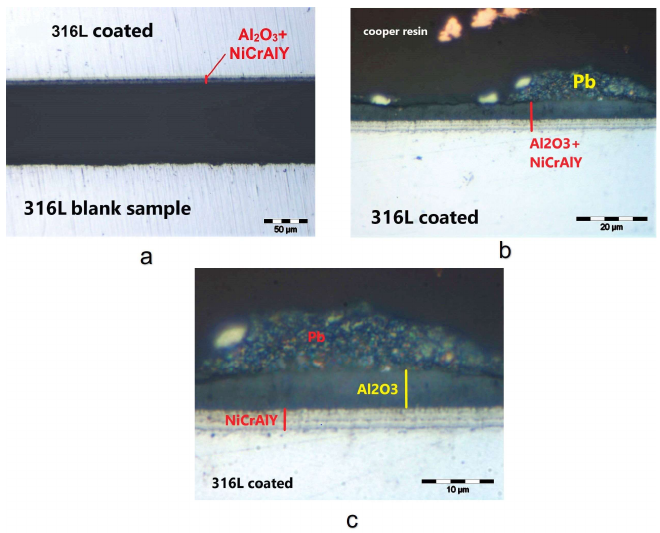
Figure 13. Cross section of the AISI 316L coated samples after being tested for 500 h in liquid lead at different magnifications: 240× ( a ), 1000× ( b ), and 2000× ( c ).